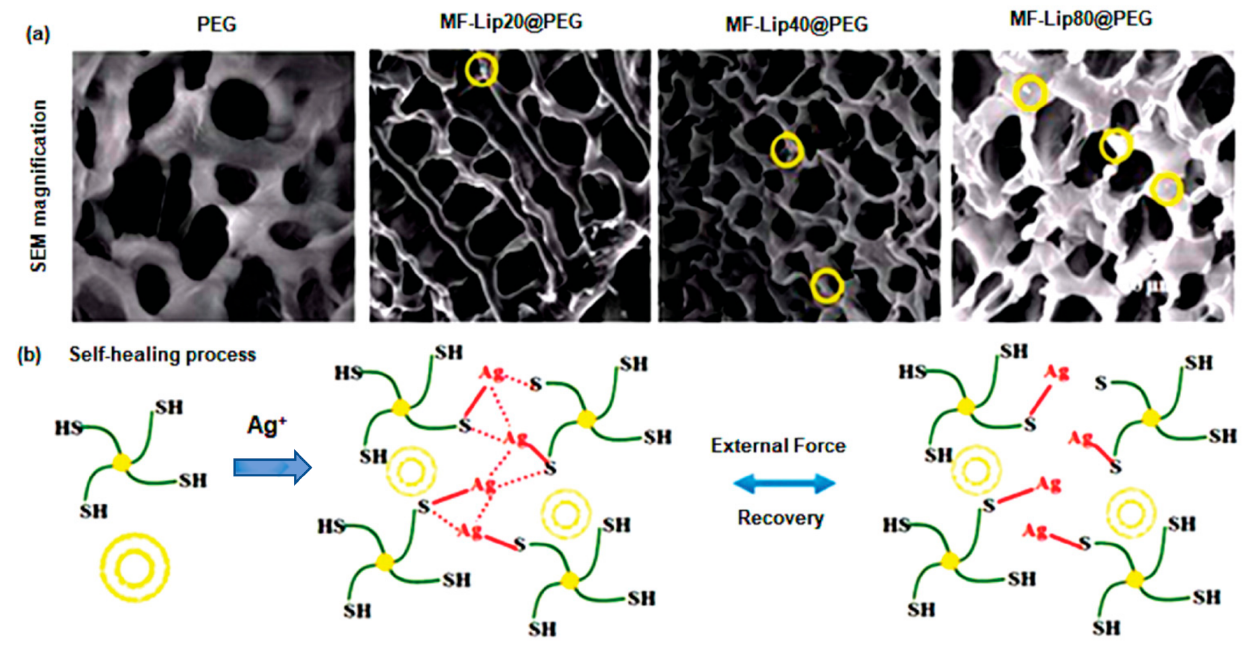
Figure 7. Microscopic examination and special features of MF-Lip@PEG hydrogels. ( a ) SEM images (yellow circles indicate liposomes). ( b ) Self-healing process in vitro drug release kinetics. This figure is adapted from Mao et al. [135]. Yellow bilayer circle indicates liposome and green marked line connected with solid yellow circle indicates PEG.“This study is under Creative Commons Attribution 4.0 International License, which permits use, sharing, adaptation, distribution, and reproduction in any medium or format, as long as you give appropriate credit to the original author(s) and the source by/4.0/, accessed on 19 October 2022)”. MF-Lip: Mangiferin liposome; PEG: Polyethylene